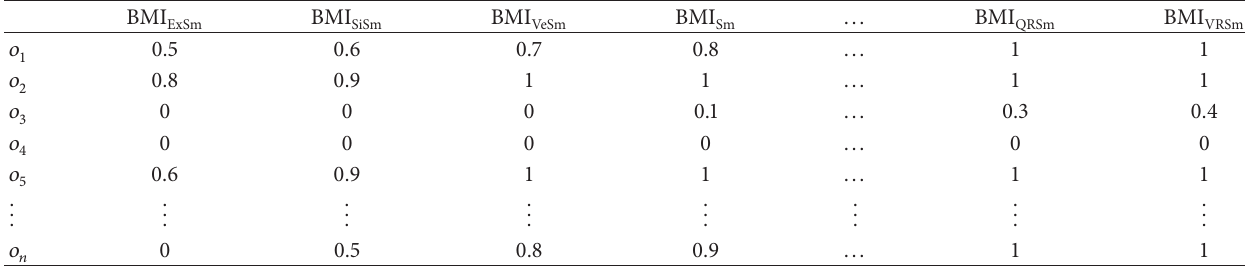
Table5:ExampleofapartofafuzzyGUHAtablewithvariableBMIandonecanonicaladjectiveSm.BMI denotes the fuzzy set “Significantly Small Body-Mass-Index,” and so forth. Objects 𝑜 𝑖 are particular patients Small Body-Mass-Index”, BMI SiSm and numbers in the table are their membership degrees in particular fuzzy